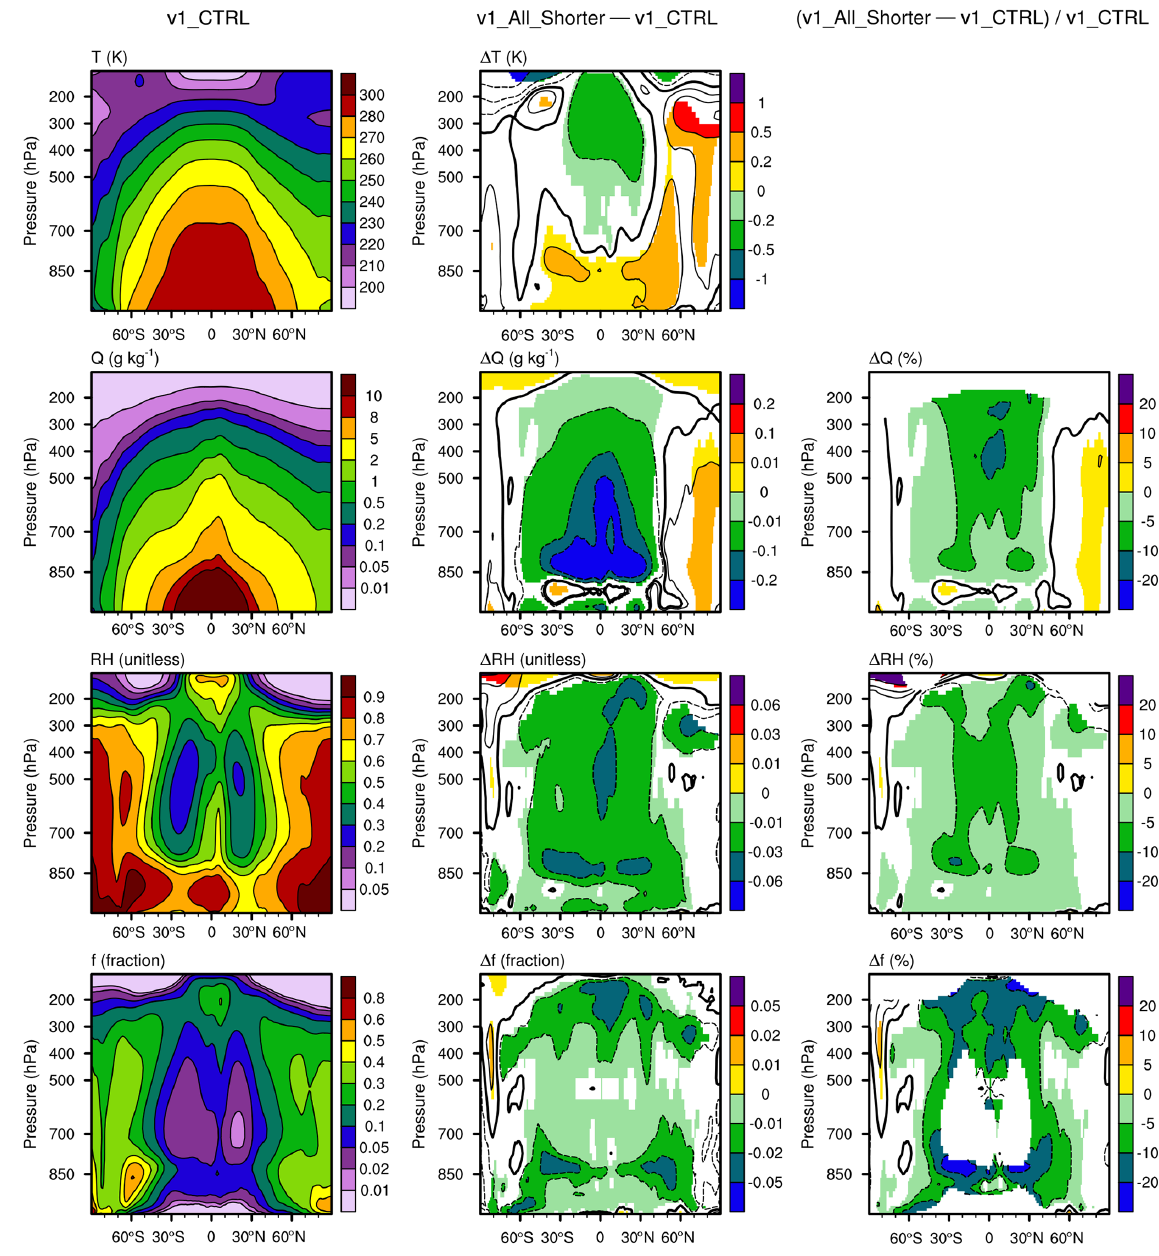
Figure 4. Left column: 10-year mean zonally averaged air temperature ( T ), specific humidity ( Q ), relative humidity (RH), and cloud fraction ( f ) in simulation v1_CTRL. Middle column: differences between v1_All_Shorter and v1_CTRL. Right column: relative differences with respect to v1_CTRL. Statistically insignificant differences are masked out in white. The simulation setups are described in Sect. 2.3 and also summarized in group I in Tables 1 and A1. Schematics depicting the time integration loop and different step sizes can be found in Fig.